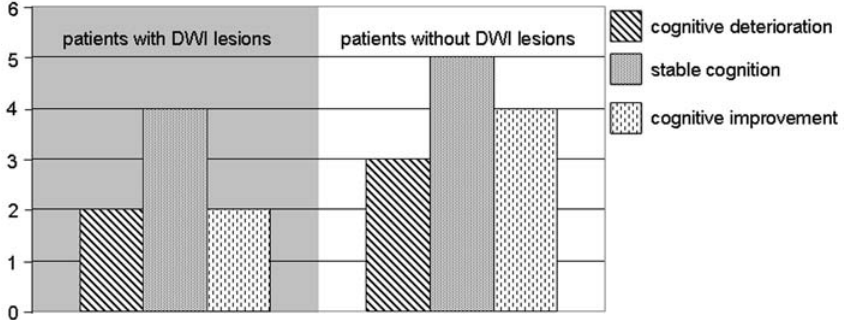
Figure 4. Number of patients who cognitively deteriorated, remained stable or improved after the intervention, separately displayed according to the incidence of new DWI lesions.